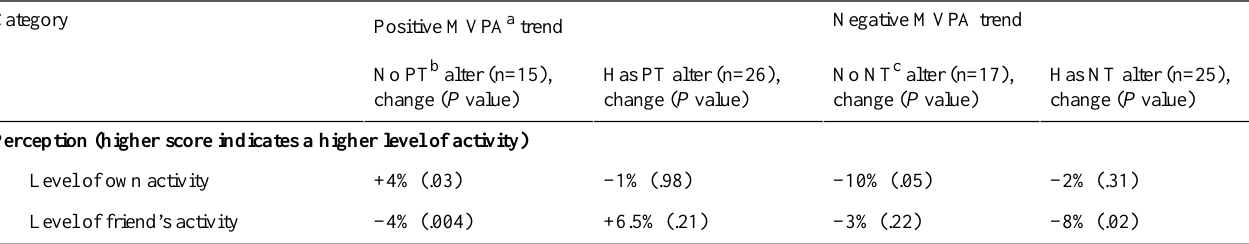
Table 5. Summary of descriptive statistics related to perceptions of participants’ own physical activity and their friend’s physical activity based on survey responses stratified by presence of same-type alters in individuals’ ego networks. Change refers to the percent difference between the average score for the first and last